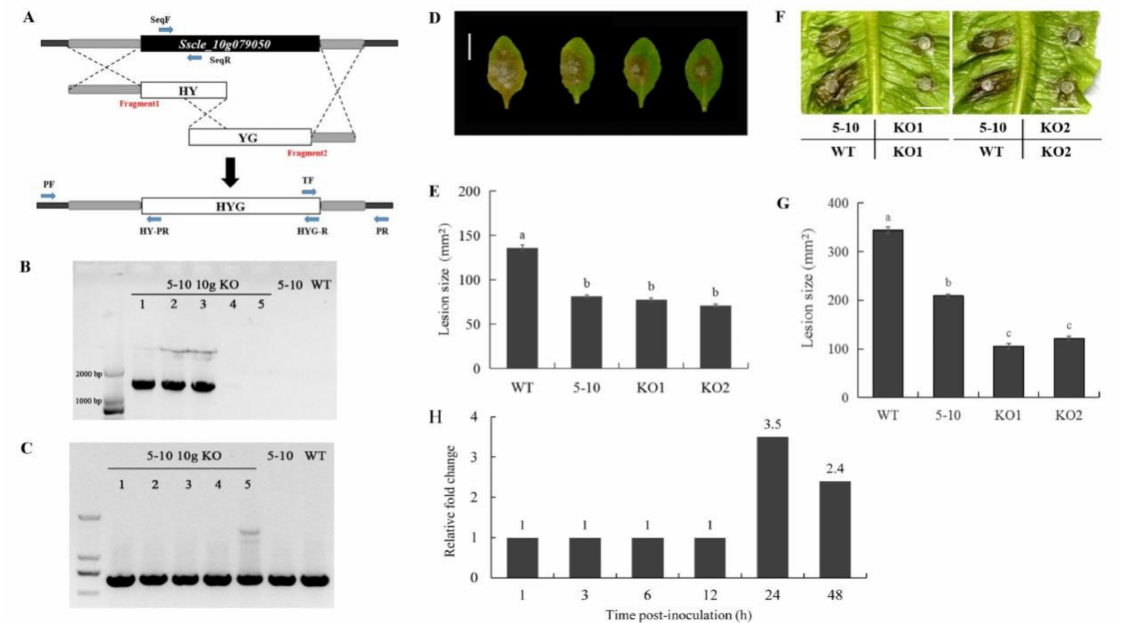
Figure 6. Knocking out Sscle_10g079050 phenocopies 5–10 and exhibit reduced virulence. ( A ) Split marker method illustration. Fragment 1 is composed of the upstream sequence of the target gene and the first half of hygromycin-resistance gene (HY), and fragment 2 is composed of the second half of hygromycin-resistance gene (YG) and downstream sequence of the target gene. Once transformed into protoplasts, the two fragments can replace the target gene with hygromycin-resistance gene (HYG) by homologous recombination. ( B ) Agarose gel electrophoresis illustrating the fragments amplified with primers of PF and HY-PR. ( C ) Agarose gel electrophoresis illustrating the fragments amplified with primers of SeqF and SeqR. ( D , F ) Image of lesions on leaves of Arabidopsis ( D ) and lettuce ( F ) caused by fungal infection. Bar = 10 mm. Data were recorded at 36 h post-inoculation (hpi). ( E , G ) Quantification of lesion size of WT, 5–10, and Sscle_10g079050 knockout mutants on leaves of Arabidopsis ( E ) and lettuce ( G ). ImageJ was used to analyze lesion size. Experiments were conducted at least three times. Error bars represent SE. Statistical significance was analyzed using Student’s t -Test. a, b in ( E ) and a, b, c in ( G ) represent different significance levels. ( H ) Expression of Sscle_10g079050 during infection of Brassica napus . Data were extracted from publicly available RNA-Seq dataset [27]. Fold change relative to 0 h post inoculation (hpi). 1: No significant change in